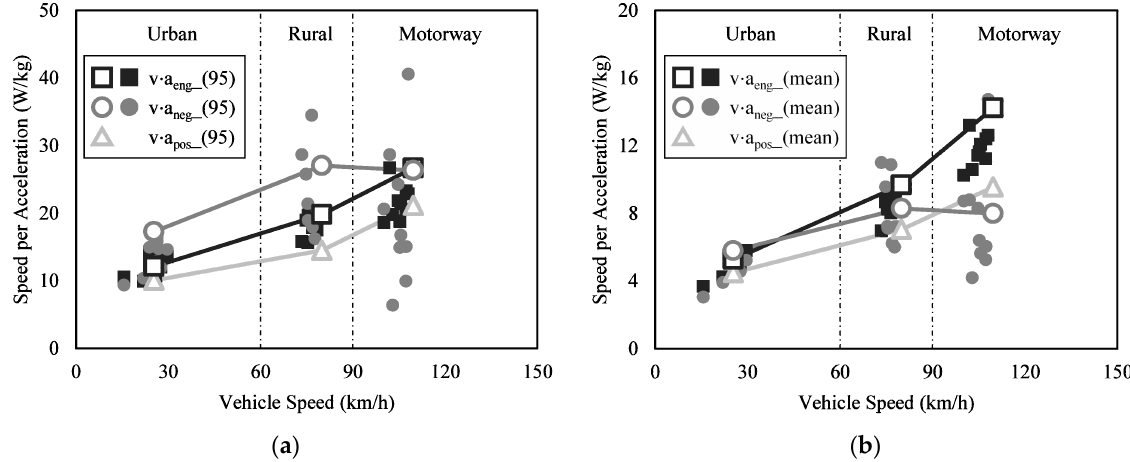
Figure 10. Comparisons of speed per acceleration for the 10 test cases. ( a ) The v·a_(95) comparisons. ( b ) The v·a_(mean) comparisons.